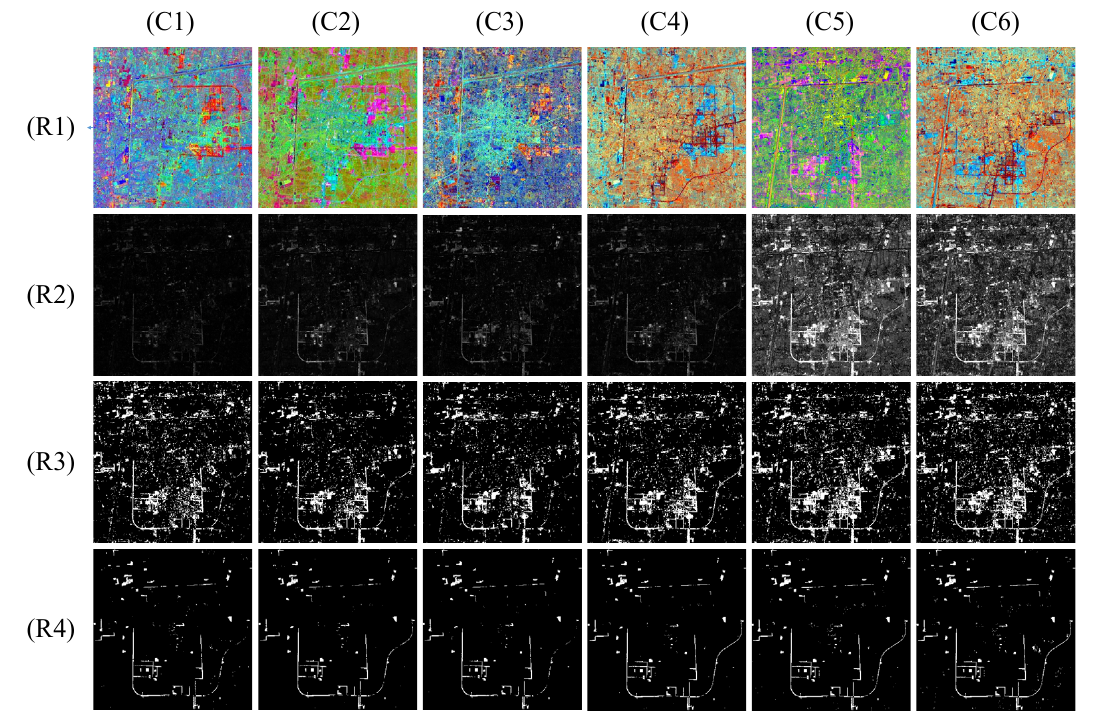
Figure 9. Visualization results of different operation stages on dataset ‘Taizhou’; (R1) Divergence Maps, (R2) Alteration Intensity Maps, (R3) Binary Alteration Maps (entire image), and (R4) Binary Alteration Maps (known areas); (C1) DSFA-64-2, (C2) DSFA-128-2, (C3) DSFA-256-2, (C4) ADM-D-PRNs using USFA, (C5) ADM-D-PRNs using IRMAD, and (C6) ADM-D-PRNs using PCA.